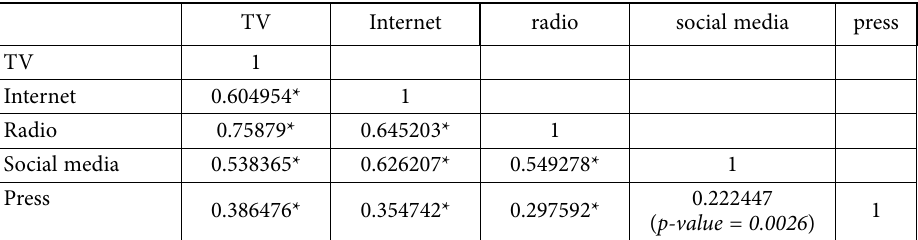
Table 2. Correlation table for each kind of media*(source: own elaboration based on data from the information agency,